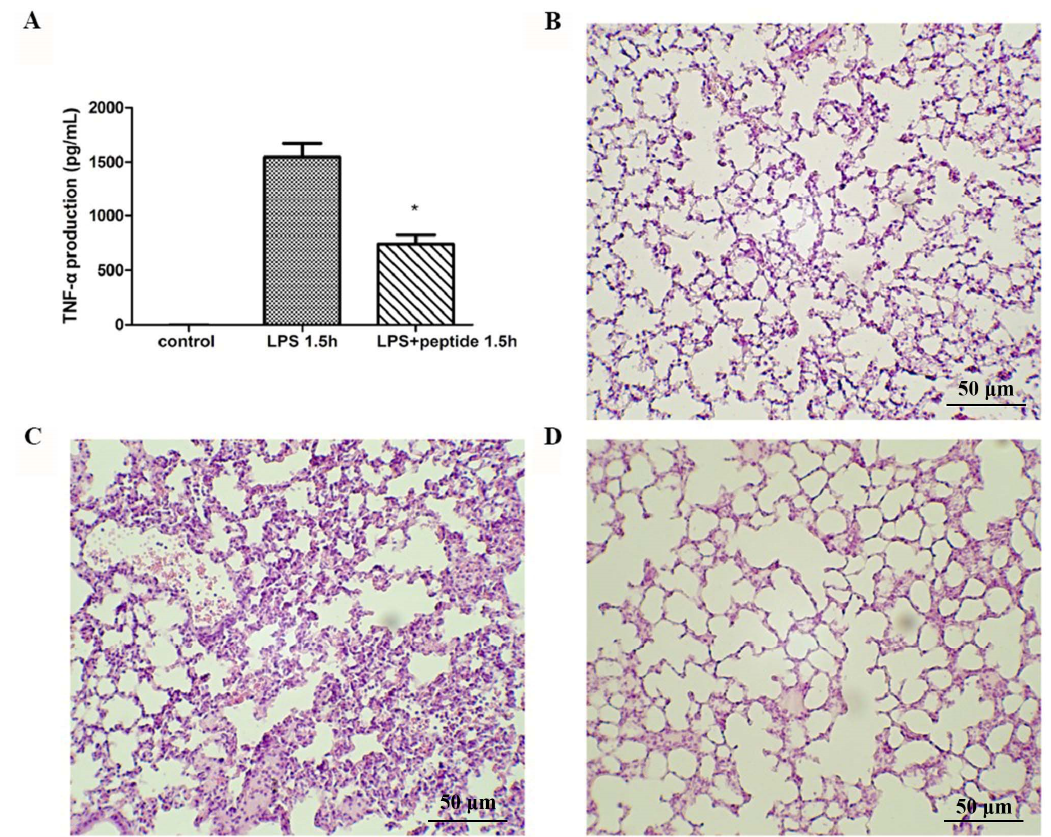
Figure 6. Suppression of LPS-stimulated inflammation in endotoxemic mice (C57BL/6) by KR12AGPWR6. ( A ) LPS-stimulated TNF-α release 1.5 h after injection. Excised lungs from the sacrificed mice 24 h after injection were subjected to H&E staining ( B ) control, ( C ) LPS ( D ) LPS and peptide. KR12AGPWR6 displayed the protective activity on LPS-stimulated endotoxemic mice. All scale bars = 50 μm. Results are presented as means ± standard deviations (SD); n = 5. * p < 0.05 versus LPS.